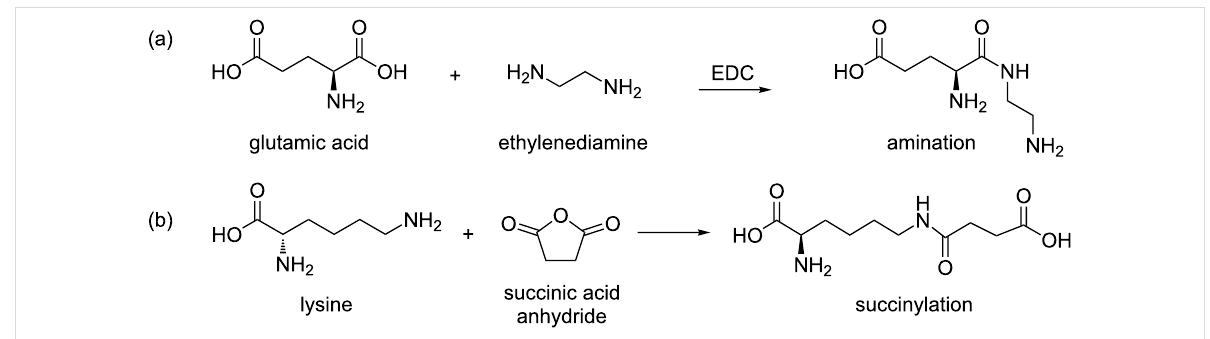
Figure 6: (a) Amination of solvent-exposed glutamic acid and aspartic acid side chains. (b) Succinylation of solvent-exposed lysine side chains.